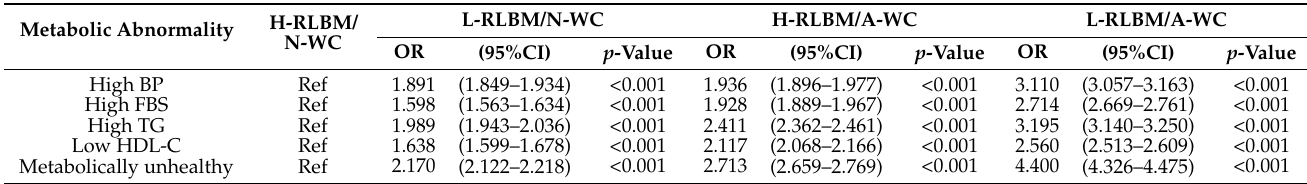
Odds ratio was adjusted by age and sex. Abbreviations: H, high; RLBM, relative lean body mass; N, normal; WC, waist circumference; L, low; A, abnormal; OR, odds ratio; CI, confidence interval; BP, blood pressure; FBS, fasting blood sugar; TG, triglycerides; HDL-C, high-density lipoprotein cholesterol.